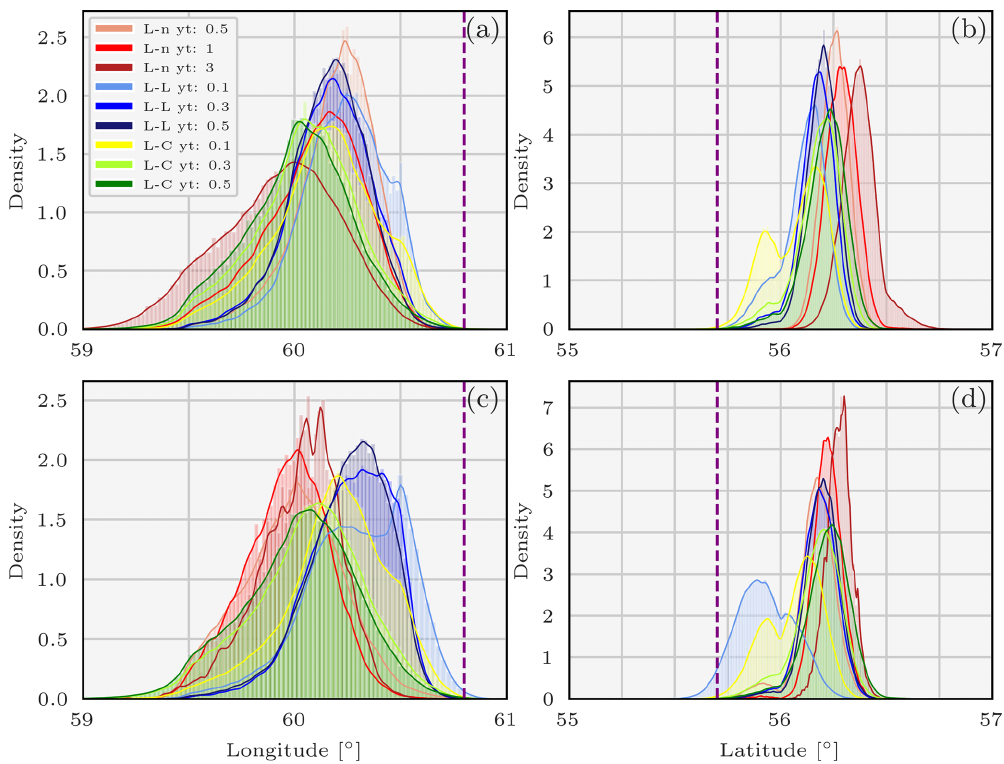
Figure 4. Pdfs of the coordinates describing the 106 Ru source sampled using the parallel tempering method and the observation-sorting algorithm and for various likelihoods in two scenarios: longitude without (a) and with observation spatial clustering in nine clusters (c) and latitude without (b) and with (d) . L-L means log-Laplace, L-n means log-normal, L-C means log-Cauchy, and y t is the likelihood threshold. The purple vertical bars represent the coordinates of the Mayak nuclear complex.